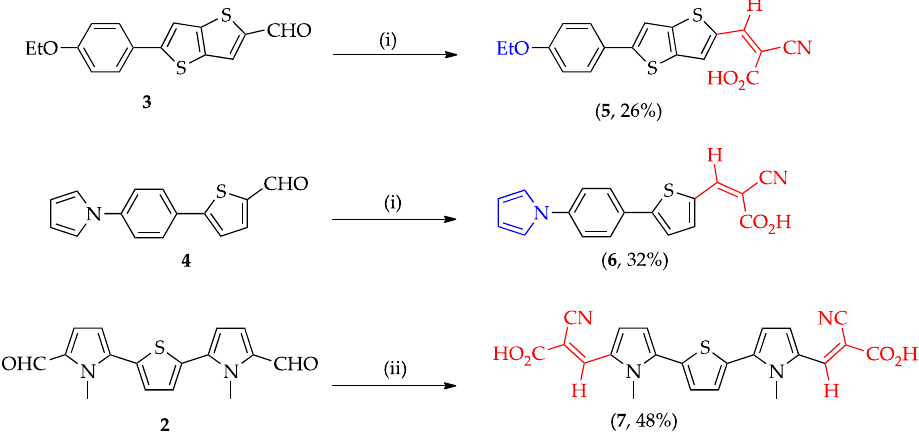
Table 1. Reaction yields and data from UV-Vis spectra and 1 H NMR for push-pull heterocyclic dyes 5–7